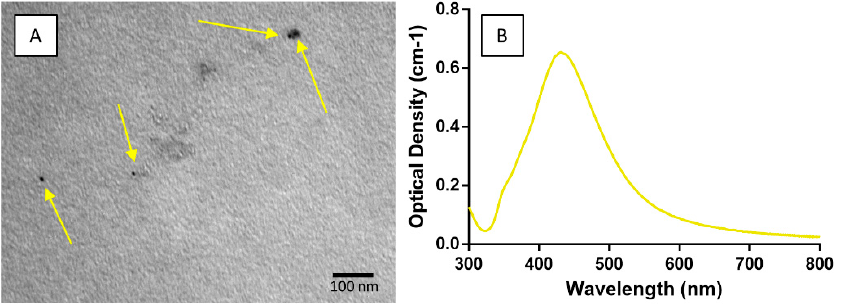
Figure 6. Evaluation of synthesized AgNPs. ( A ) Transmission electron microscopy (TEM) confirmed nanoscale particle sizes. ( B ) UV spectroscopy of AgNP suspensions verified their consistency.